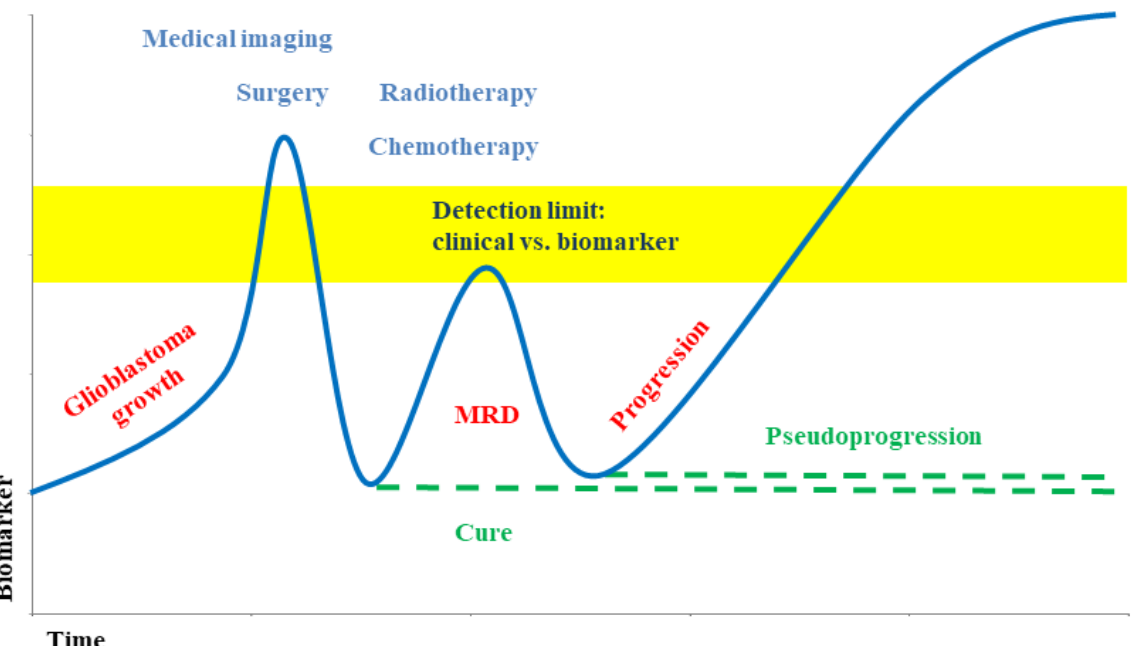
Figure 2. Biomarker level during glioblastoma development and therapy [40, 46]. Liquid biopsy supports earlier detection of minimal residual disease (MRD) and allows differentiating between progression and pseudoprogression Note. Adapted from “Liquid biopsy and primary brain tumors,” by Eibl RH, Schneemann M. Cancers (Basel). 2021;13:5429 (https://doi.org/10.3390/cancers13215429). CC BY; “Liquid biopsy for monitoring medulloblastoma,” by Eibl RH, Schneemann M. Extracell Vesicles Circ Nucl Acids. 2022;3:263–74 (http://dx.doi.org/10.20517/evcna.2022.36). CC